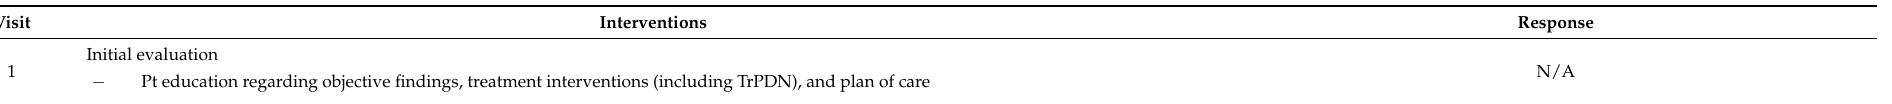
Table 2. Treatment